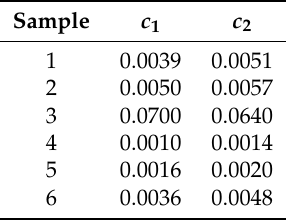
Table 5. Time constants of the permittivity tendency